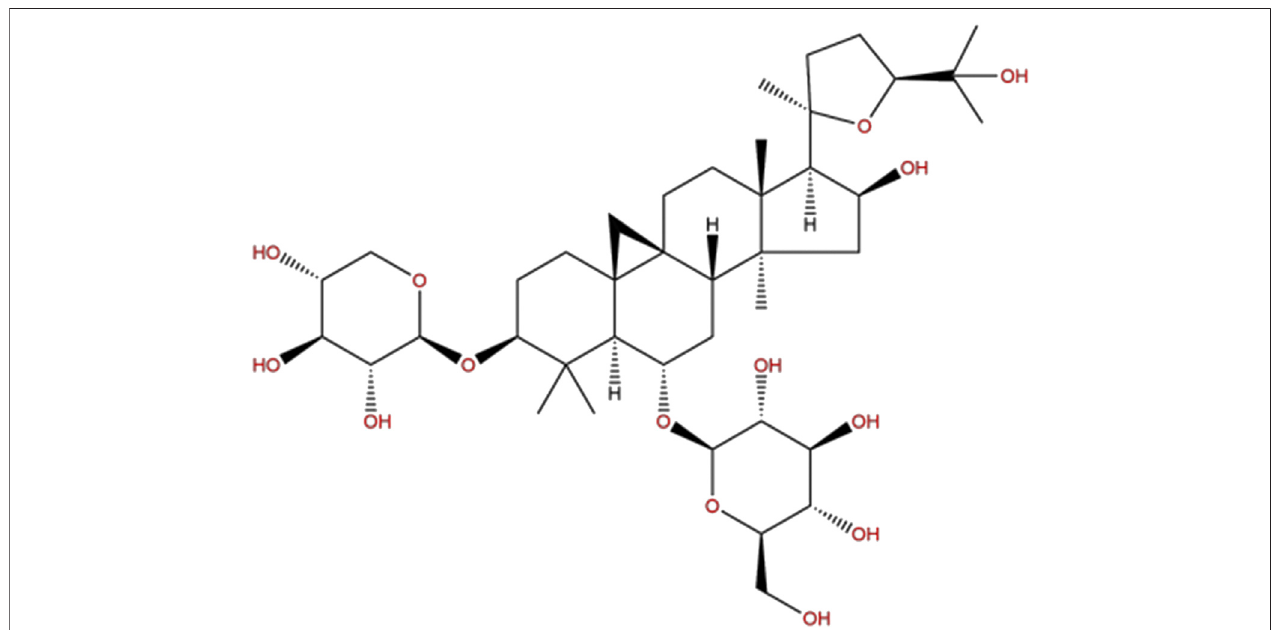
FIGURE 1 | The chemical structure of